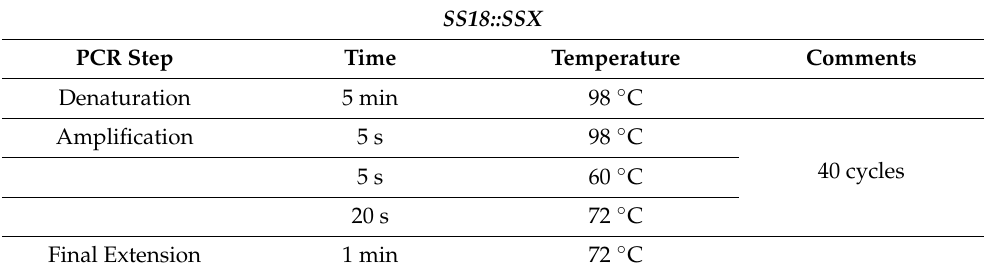
Table 5. Thermocycler conditions used for human or mouse PTGER2